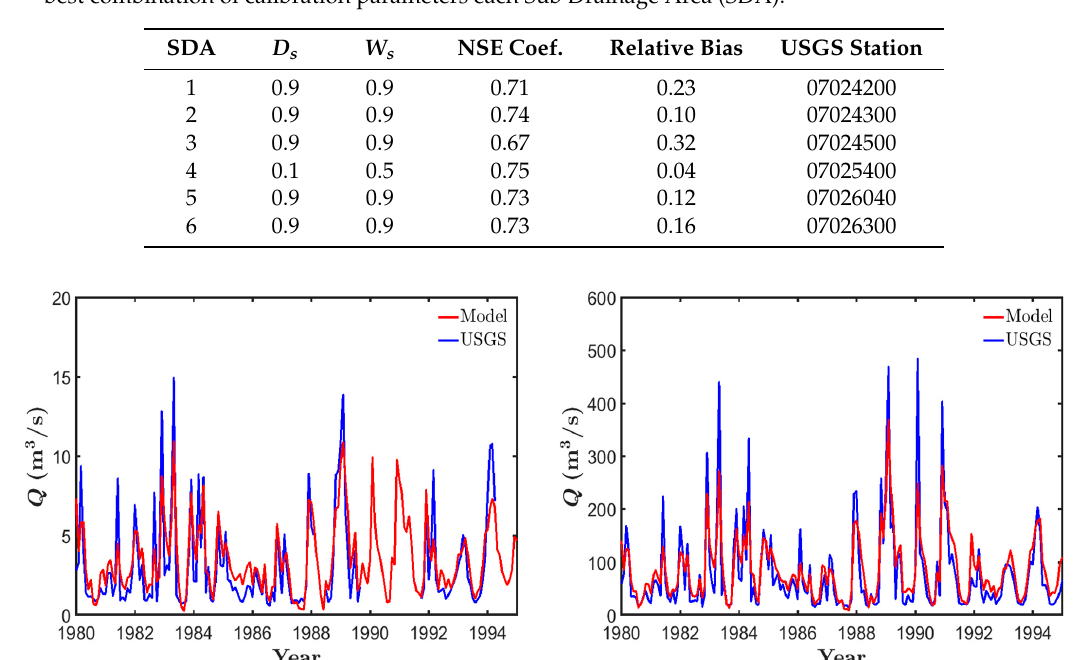
Table 3. Streamflow calibration: Nash-Sutcliffe Efficiency (NSE) Coefficient and Relative Bias for the best combination of calibration parameters each Sub Drainage Area (SDA).